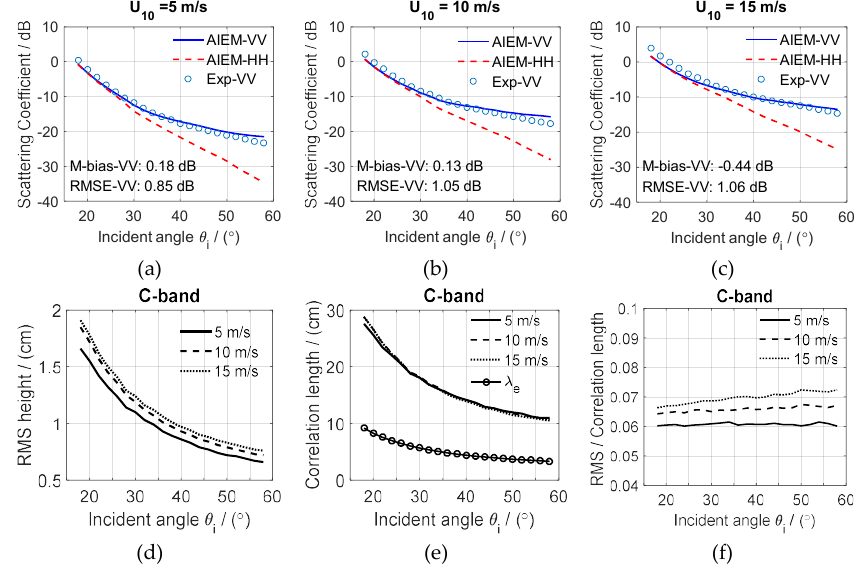
Figure 6. Comparisons of the simulated backscattering based on Apel spectrum for C-band with the CMOD7 data (no HH polarization) at the wind speeds of 5 m/s, 10 m/s, and 15 m/s (the first row: ( a ) 5 m/s; ( b ) 10 m/s; ( c ) 15 m/s) and the corresponding roughness parameters (the second row: ( d ) RMS height, ( e ) correlation length, and ( f ) the ratio of RMS and correlation length).